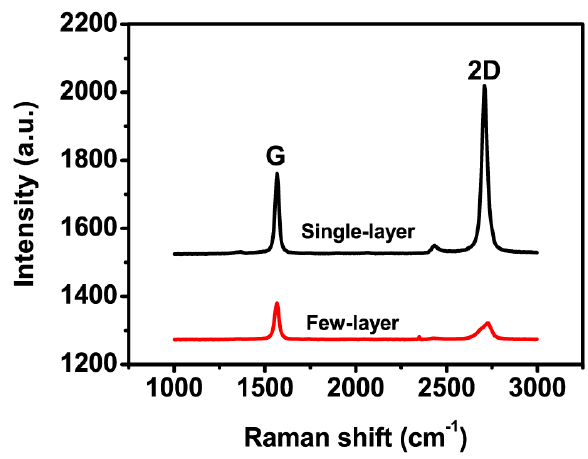
Figure 2. Raman spectra recorded at different regions of 3D graphene foam.